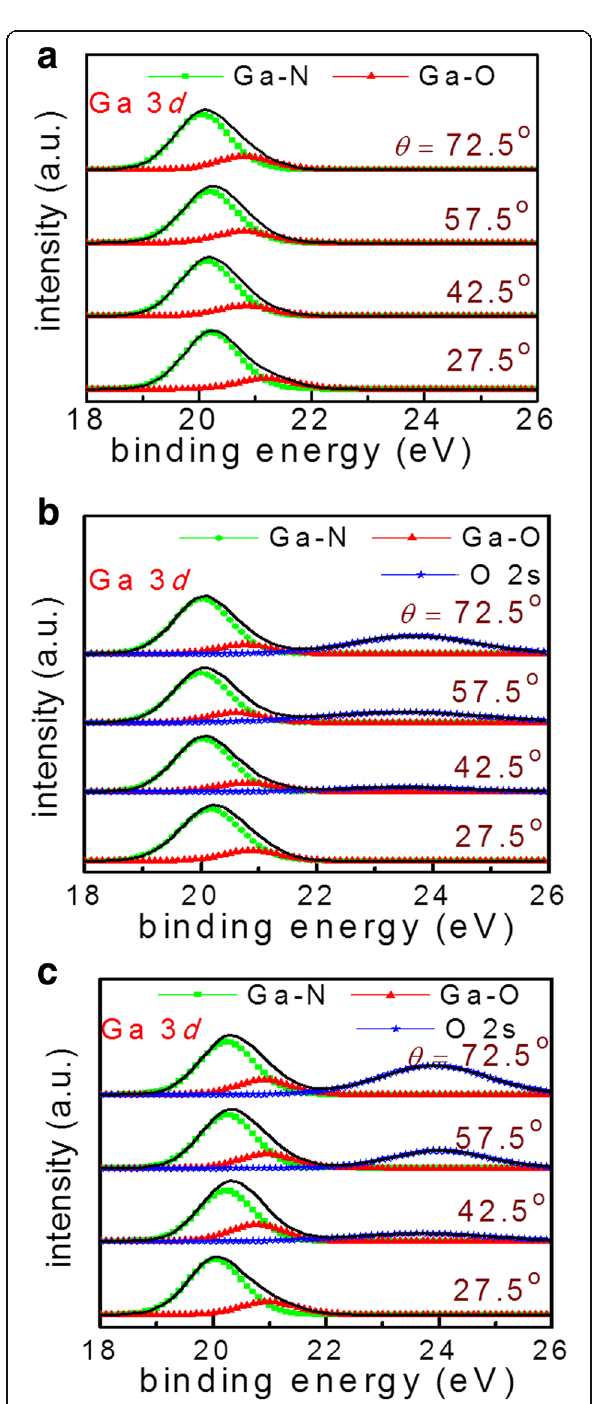
Fig. 1 The XPS Ga 3 d core-level spectra for a S1, b S2, and c S3